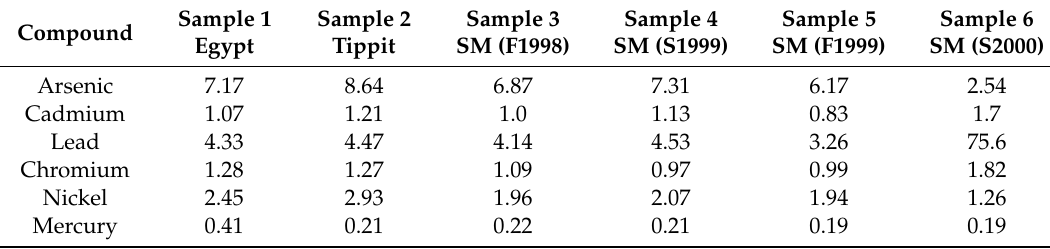
Table 4. Metals (ppm, µ g / g dry weight) in guano from Shell Mountain, Egypt, and Tippit Caves.